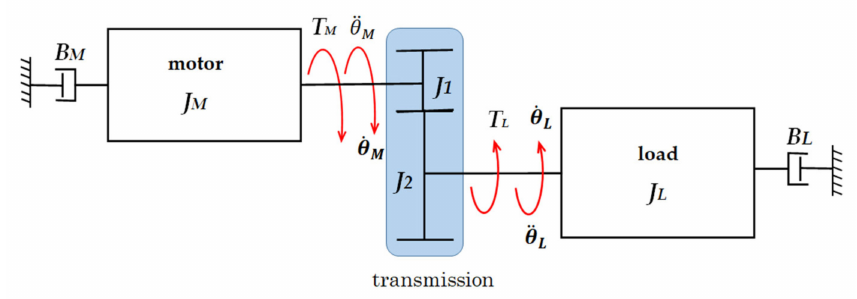
Figure 6. Schematic of the simplified model of a mechanical